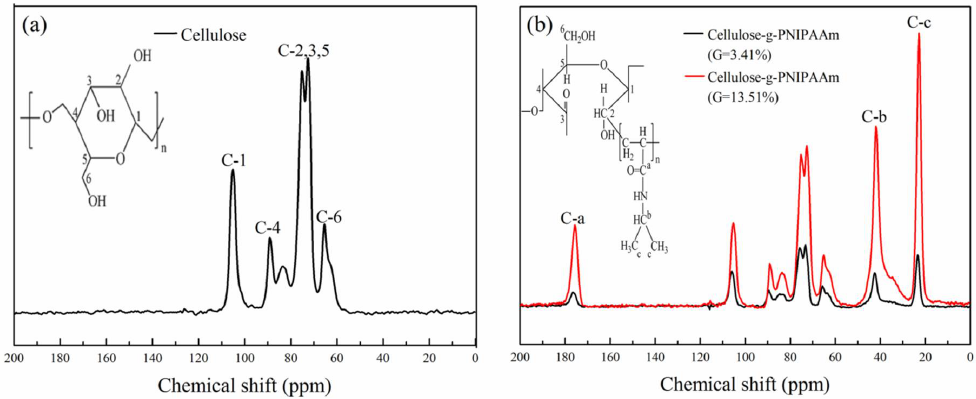
Figure 3. The 13 C solid-state Nuclear Magnetic Resonance spectra of cellulose ( a ) and cellulose- g -PNIPAAm (G EA = 3.14% and 13.51%) ( b ).